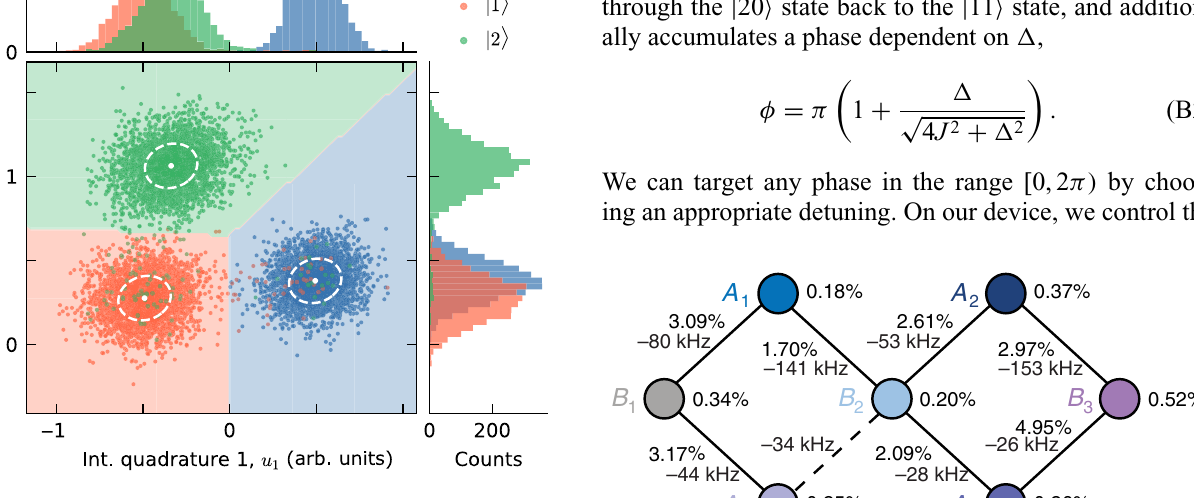
FIG. 8. Three-level single-shot readout characterization of qubit A 1 with ground-state heralding. We display the first 3000 of the 20 000 single-shot measurements for each state. The blue (red) (green) shaded area correspond to the region of the integrated quadrature plane in which a measured data point is assigned to the | 0 (cid:4) ( | 1 (cid:4) ) ( | 2 (cid:4) ) state. The white dots and dashed white lines correspond to the mean and the 1 σ -confidence ellipse of each mode of the mixture model.